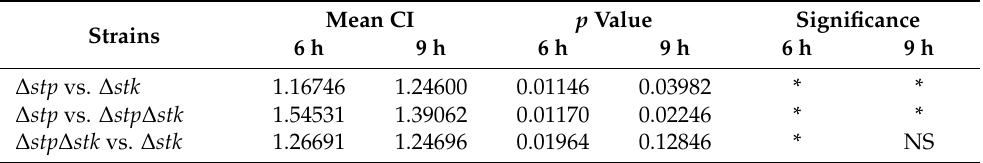
Table 1. Competitive index ( n =